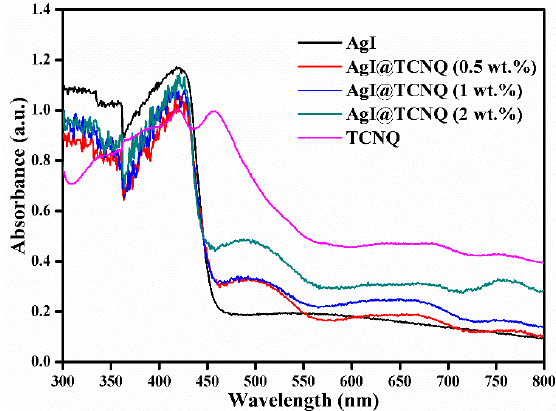
Figure 3. Ultraviloet-visible (UV)-vis diffuse reflectance spectra of the composites.